Question: Produce a descriptive caption suitable for publication.
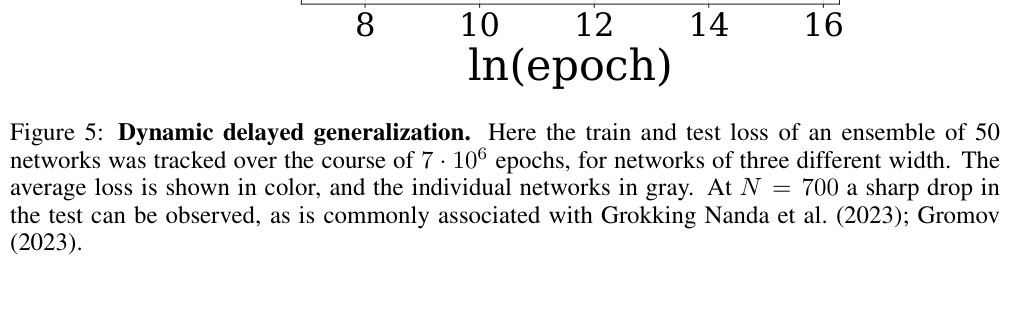
Answer: Dynamic delayed generalization. Here the train and test loss of an ensemble of 50 networks was tracked over the course of 7 · 106 epochs, for networks of three different width. The average loss is shown in color, and the individual networks in gray. At N = 700 a sharp drop in the test can be observed, as is commonly associated with Grokking Nanda et al. (2023); Gromov (2023).